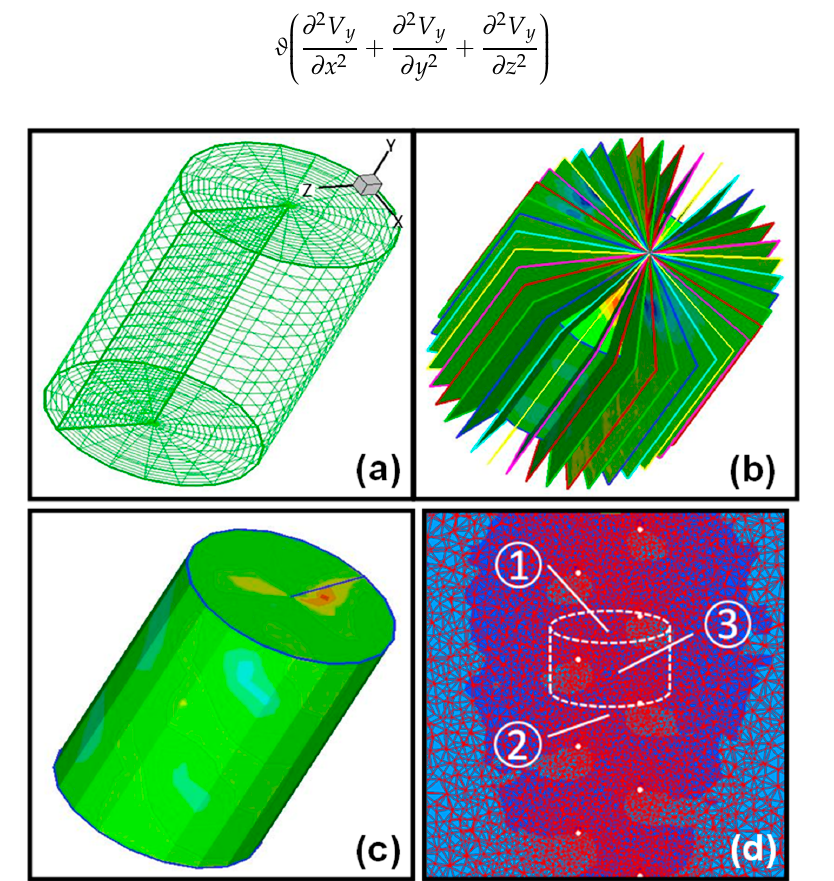
Figure 3. Volumetric PIV data acquisition and analysis methodology. ( a ) Structured C-grid generated for radial (2C/3C) PIV data interpolation. ( b ) 20 PIV slices and ( c ) interpolated volumetric data. ( d ) Sketch of the control volume that spans one pitch of flagella segment for thrust and dissipation calculation and corresponding control surfaces.